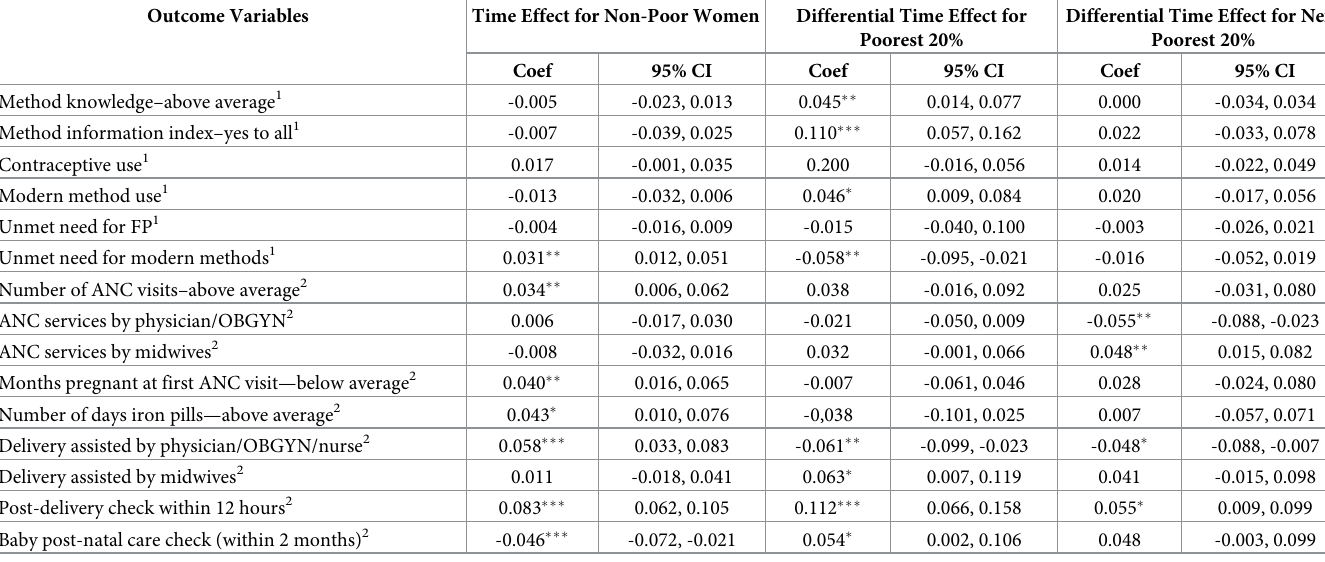
Table 5. Difference-in-differences regression estimates of comparative changes in selected outcomes for non-poor, poor, and near-poor women,